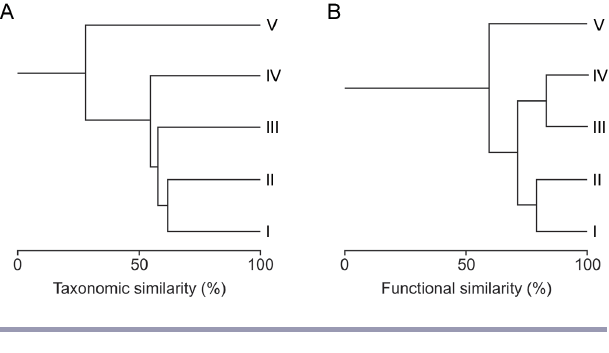
Table 3 . Results of analysis of covariance paired comparisons of rank/abundance slopes among fragment size categories.